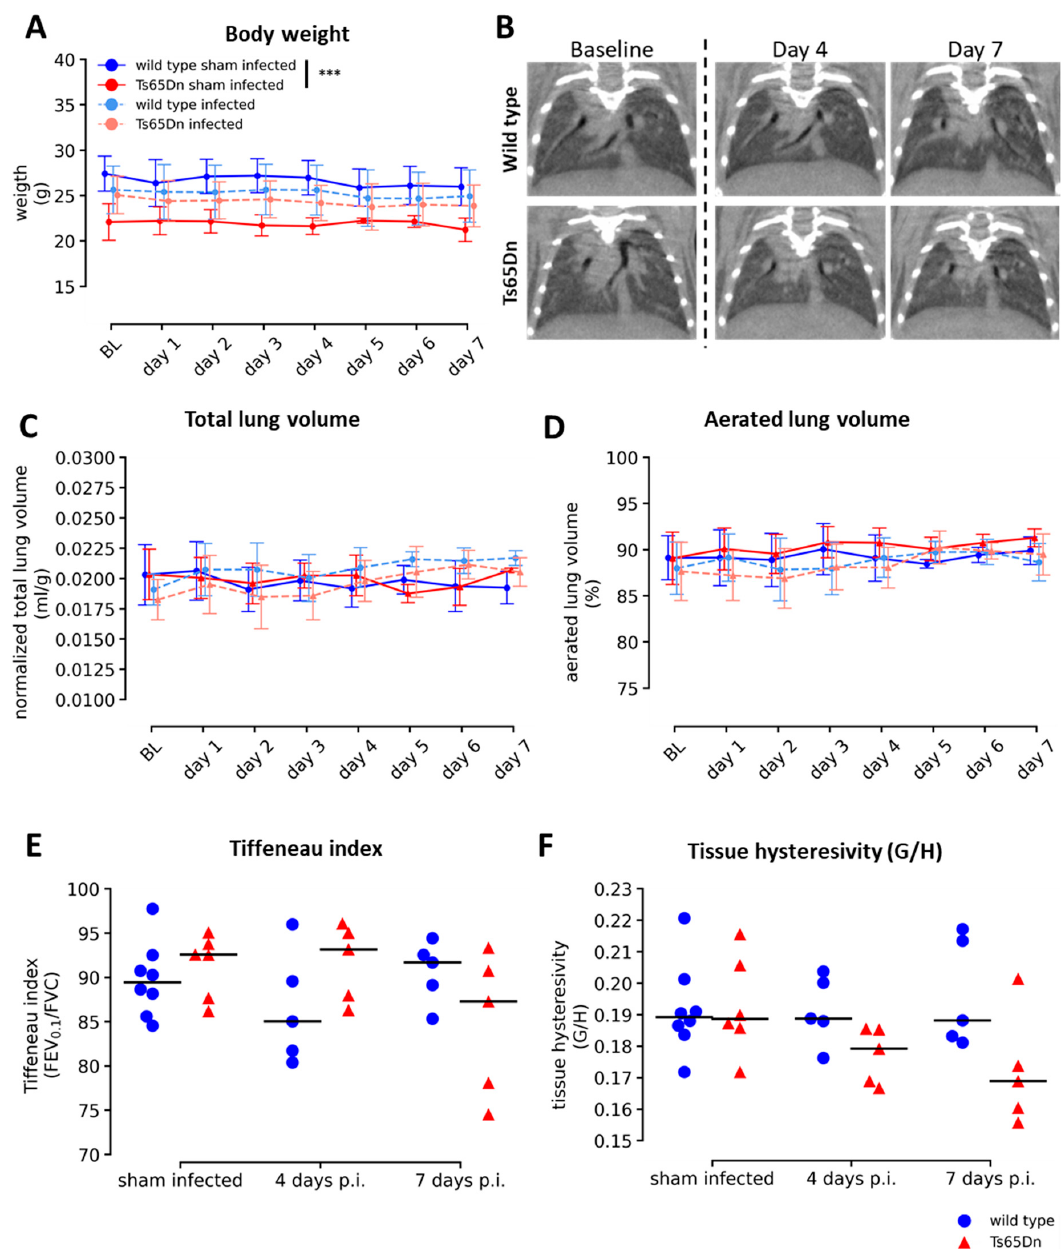
Figure 3. Overall pathological signs of a rhRSV-Luc infection in wild type and Ts65Dn mice. ( A ) Body weight was monitored in rhRSV-Luc and sham infected mice over seven days and expressed as mean with standard deviations. ( B ) Representative images of the frontal view of longitudinal lung micro-CT images from a wild type and Ts65Dn mouse at baseline, day four and day seven. ( C ) Representative graph showing the quantification of micro-CT-derived biomarkers showing total lung volume normalized to body weight. ( D ) Aerated lung volume expressed as percentage of TLV in wild type and Ts65Dn mice after intranasal instillation with dPBS or rhRSV-Luc. The number of mice were: wild type sham-infected (N = 7, 4 days p.i. N = 3, 7 days p.i. N = 4), Ts65Dn sham infected (N = 8, 4 days p.i. N = 4, 7 days p.i. N = 4), wild type infected (N = 11, 4 days p.i. N = 6, 7 days p.i. N = 5), and Ts65Dn infected (N = 10, 4 days p.i. N = 5, 7 days p.i. N = 5). ( E ) Pulmonary lung function data re fl ecting Ti ff eneau index. ( F ) Tissue hysteresivity in sham-infected, four-day and seven-day infection in wild type (blue circle) and Ts65Dn (red triangle) mice, expressed as individual values and group median. *** p < 0.005.